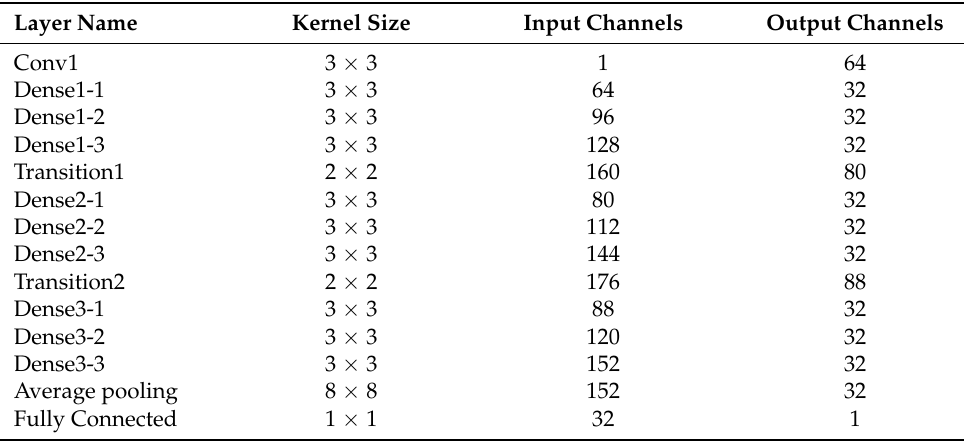
Table 2. Hyperparameters of the networks’